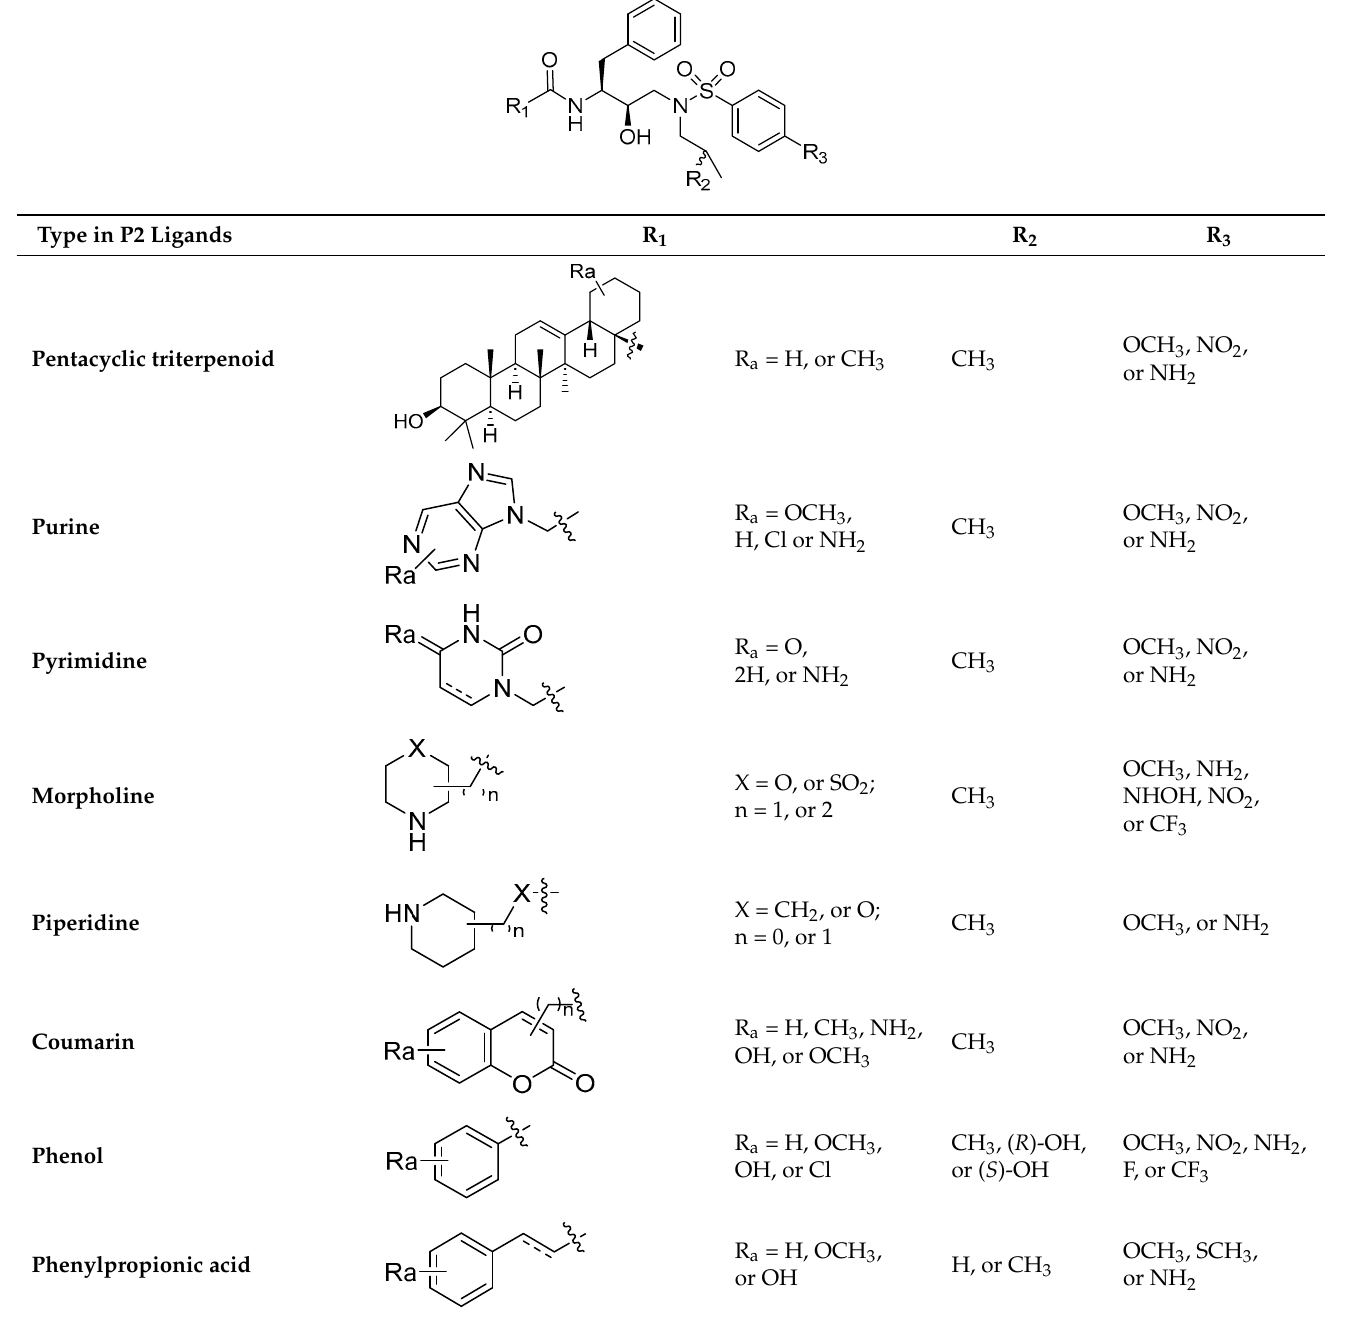
Table 1. HIV-1 protease inhibitors with different types in the P2 ligand.